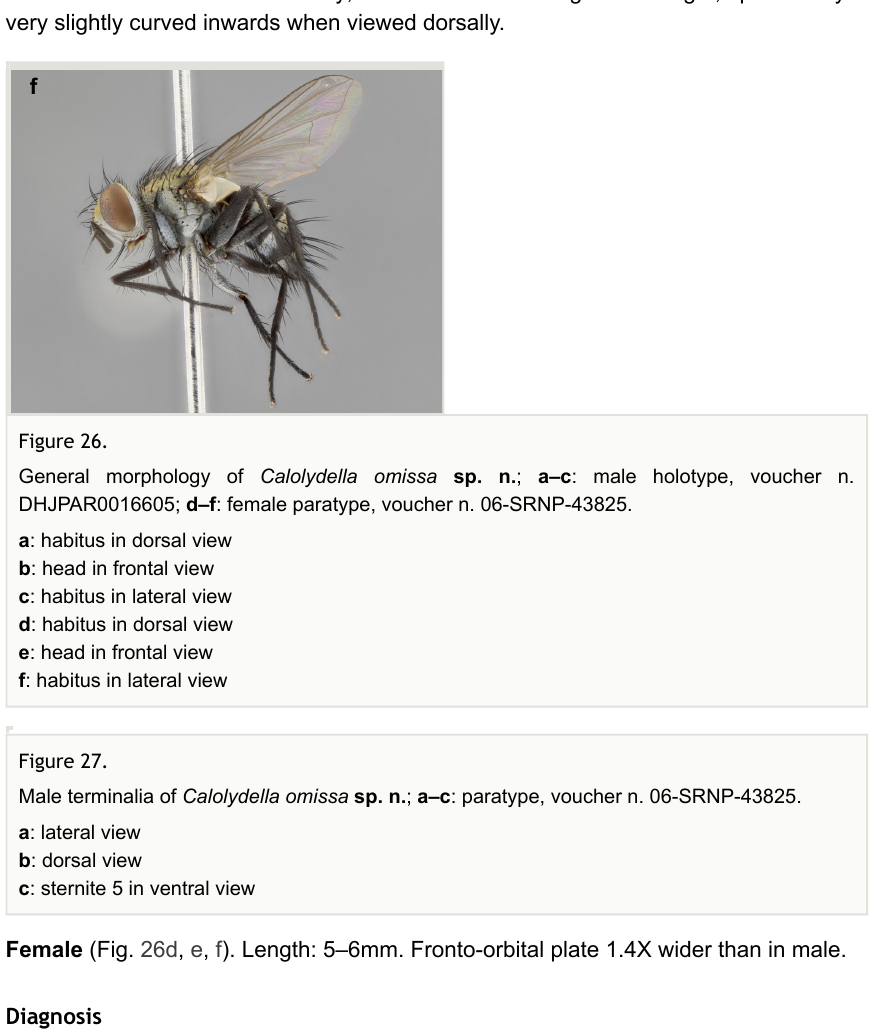
(Fig. 27b), in dorsal view, separated by a narrow gap but rejoining at apex; each cercus long and very slightly tapered, almost of equal width along entire length; cercus slender with an upward bend when viewed laterally; setose along its entire length. Surstylus (Fig. 27a) slender and digitiform with a slight upward curve, appearing 0.2X shorter than cercus when viewed laterally; with short setae along entire length; tip of surstylus very slightly curved inwards when viewed dorsally.